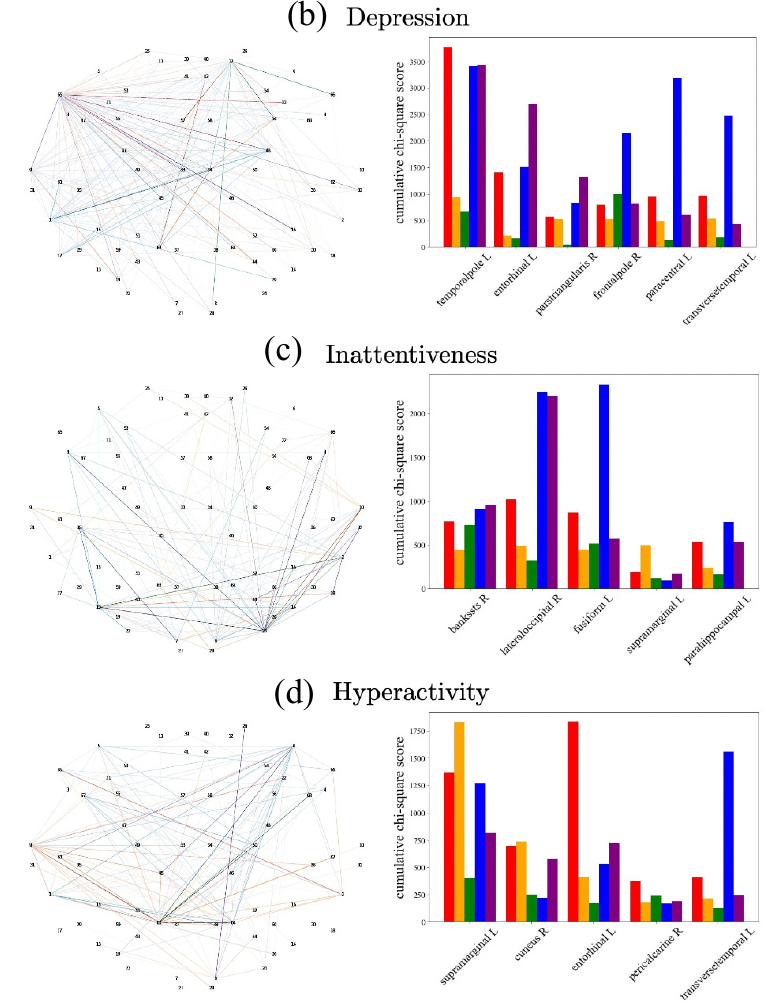
Figure 7. Tasks with highest cumulative chi-square scores across ROIs. ( left ) Topographical plot of ROIs whose edges are colored to represent the cognitive task with the largest cumulative chi-square score. ( right ) The cumulative chi-square value of each of the 5 tasks in the top 5 ROIs. Go Green I is a go-nogo selective-attention task, Go Green II is a go-nogo response inhibition task, Lost Star is a working memory task, Middle Fish is an interference processing task, and Face Off is an emotional interference processing task.